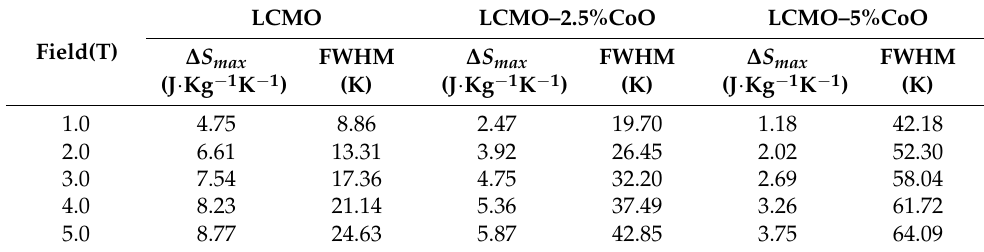
Table 6. Magnetic field dependence of maximum entropy change. and FWHM of LCMO–CoO composite